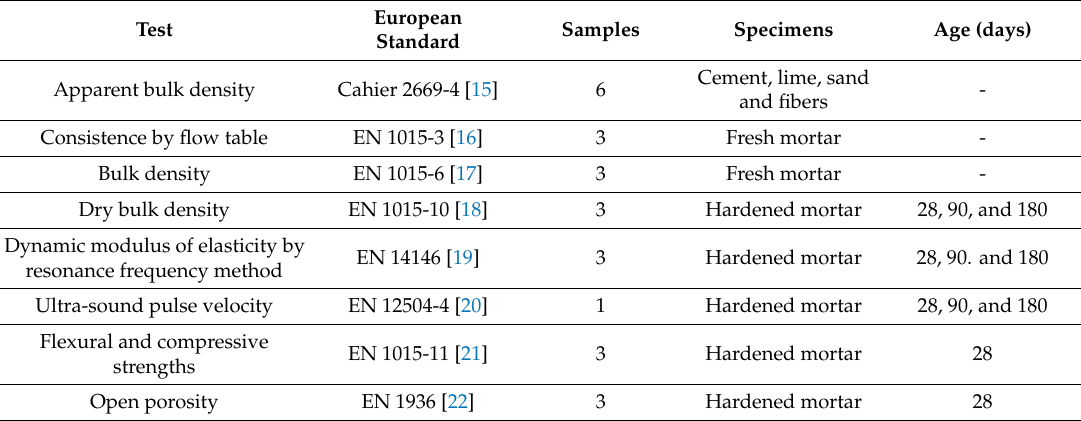
Table 3. Experimental campaign